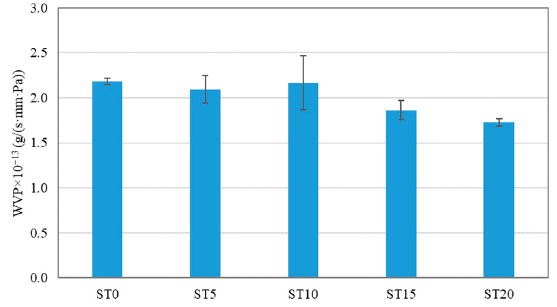
Figure 5. The WVP of SPI and SPI–BT films.